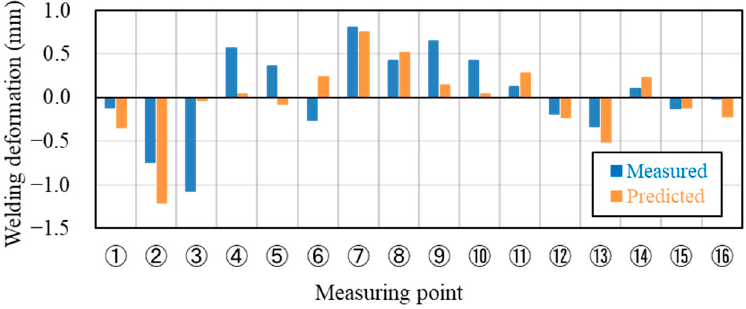
Figure 16. Bar graph of welding deformation at the measuring points.